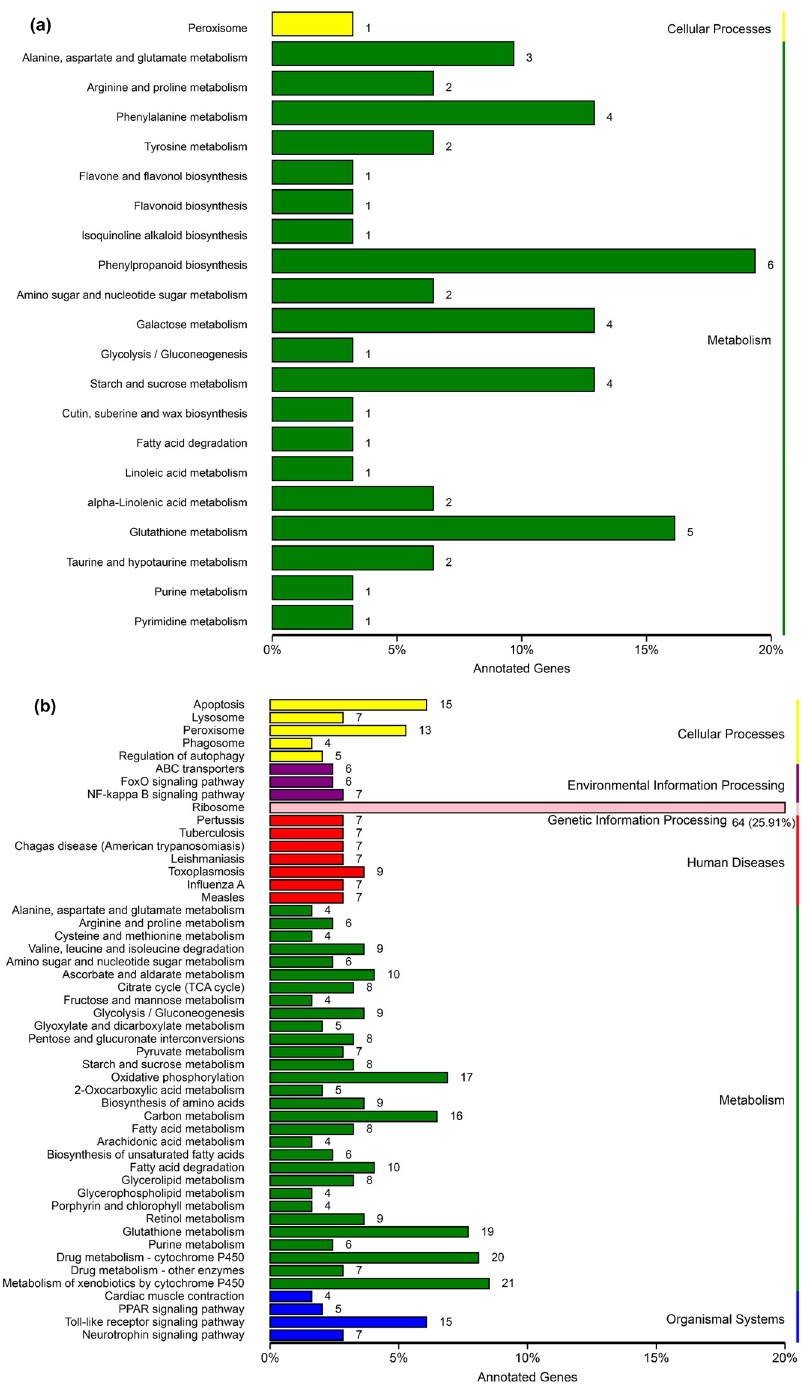
Figure 4. Kyoto Encyclopedia of Genes and Genomes (KEGG) enrichment analysis of differentially expressed genes (DEGs) of wheat roots ( a ) and Heterodera avenae juveniles ( b ) in the study. Cellular processes and metabolic pathways were enriched in wheat DEGs. Cellular processes, environmental information processing, genetic information processing, human diseases, metabolism and organismal system pathways were enriched in H. avenae DEGs. The x-axis shows the percentage of the annotated genes in each category and the number of genes is indicated at the top of the